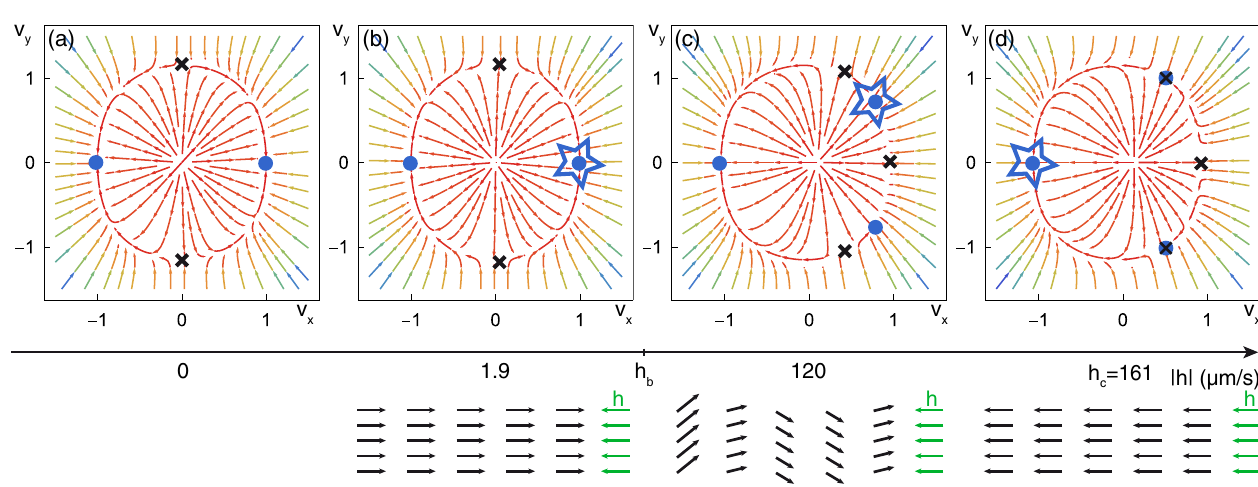
FIG. 4. Two-mode theory of the hysteretic response. We look for stationary solutions of the hydrodynamics of polar liquids taking the form v ¼ v x ð t Þ ˆ x þ v y ð t Þ cos ð qx − ω t Þ ˆ y . The problem then reduces to studying a dynamical system: ∂ t V ¼ F ð V ; h Þ , where V ¼ ð v ; v Þ . (a) Force field F ð V ; h ¼ 0 Þ in the absence of an external field, plotted for W ¼ 0 . 5 mm. The blue circles correspond to x y stable fixed points where F ¼ 0 . The crosses indicate the positions of saddle points. A trivial unstable point is located at (0,0), but is not shown. (b) Force field F ð V ; h Þ at finite h . The star symbol indicates the stationary position of the dynamical system. When j h j < h system stays in the stable fixed point, corresponding to a uniform longitudinal flow in the direction opposite to h , as sketched in the bottom panel. (c) Increasing j h j , such that the homogeneous solution of (b) becomes unstable. Another stable point emerges between two saddle points and corresponds to the buckled flow sketched in the bottom panel. Such stable buckled flows are consistent with the experimental observations of Fig. 3. (d) At j h j ¼ h , the topmost saddle point collides with the stable fixed point (superimposed cross c and dot symbols). As a result, the only stable conformation corresponds to a flow aligned with h